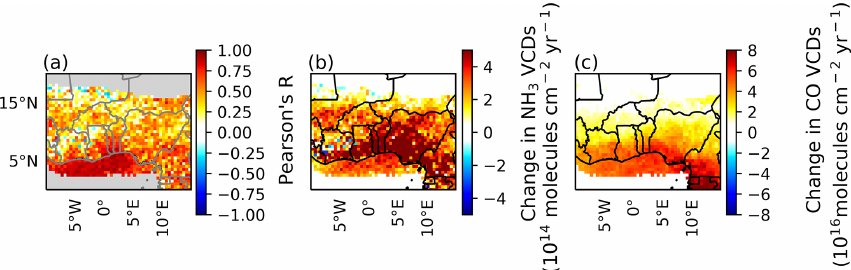
Figure 4. Correlation coefficient for the relationship between mean annual CO and NH 3 VCDs (a) , changes in NH 3 VCDs (b) and changes in CO VCDs (c) over 2008 through 2018 in West Africa. Grid cells where mean annual NH 3 VCDs for the entire period are under 5 × 10 15 molecules cm − 2 are not displayed. Results significant at P = 0 . 05 for the entire continent are presented in Fig.